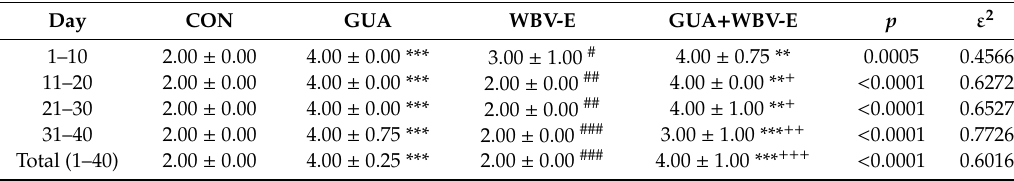
Table 5. Stool consistency of animals submitted to some